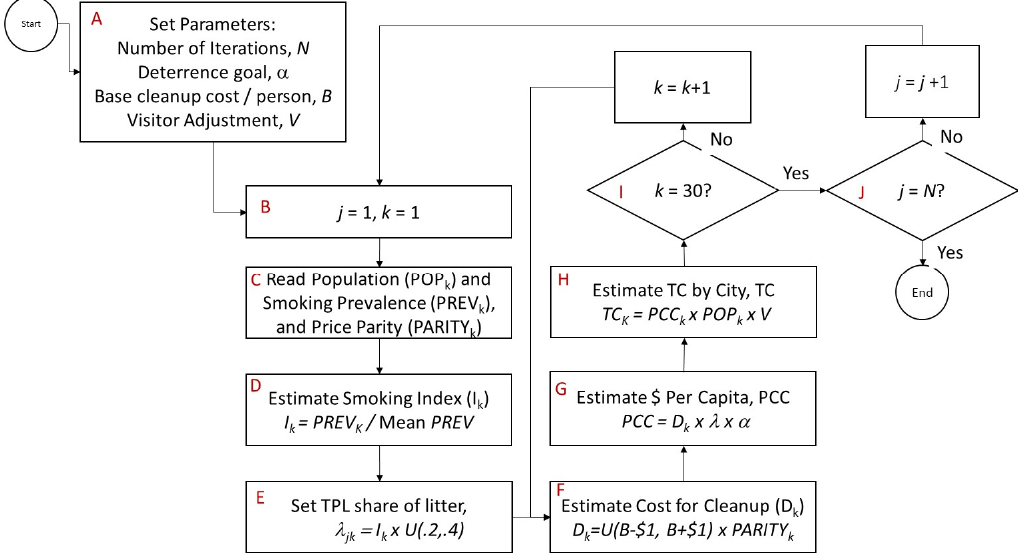
Figure 1. Simulation flowchart for estimating the total cost ranges for tobacco product waste (TPW) cleanup.